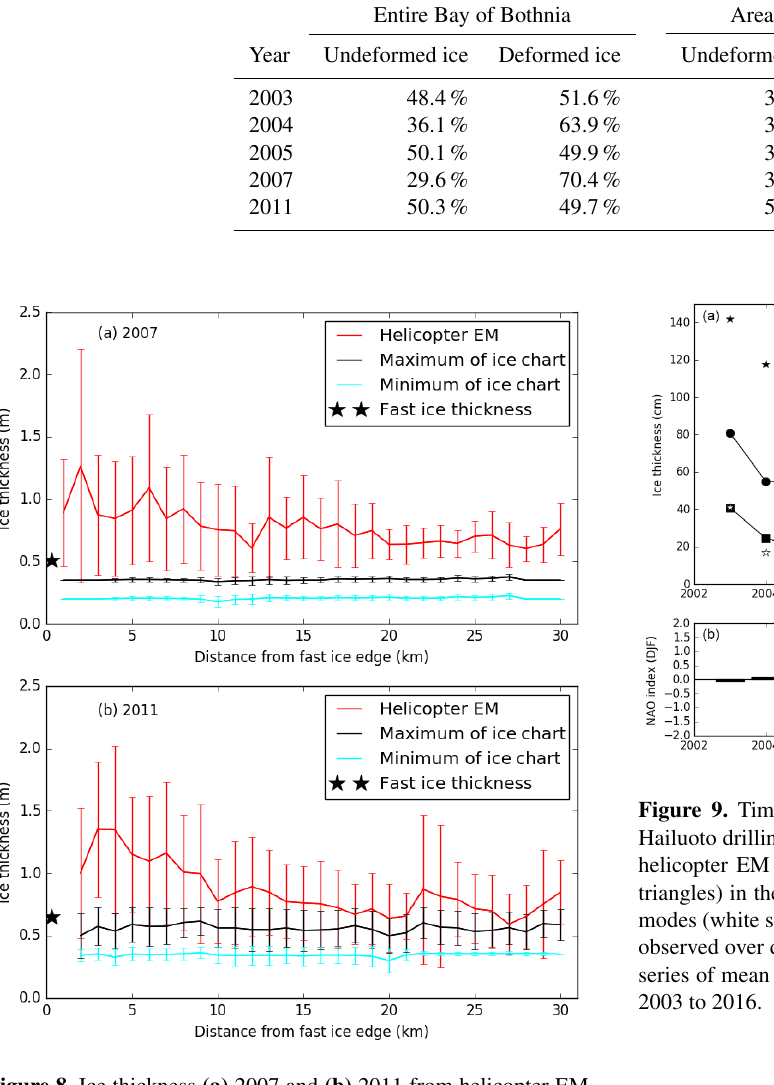
Figure 8. Ice thickness (a) 2007 and (b) 2011 from helicopter EM (red) and maximum (black) and minimum (cyan) of ice charts from the same points where helicopter EM was measured. Ice thickness is shown with the distance from the fast ice edge. The bars are ± standard deviation and the stars indicate fast ice thickness on ap- proximately 1 March in Hailuoto station.